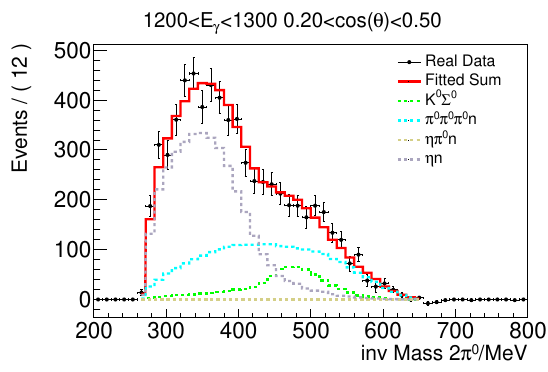
Figure 7. Example fit to 2 π 0 invariant mass spectrum. Simulated contributions to the fit labeled